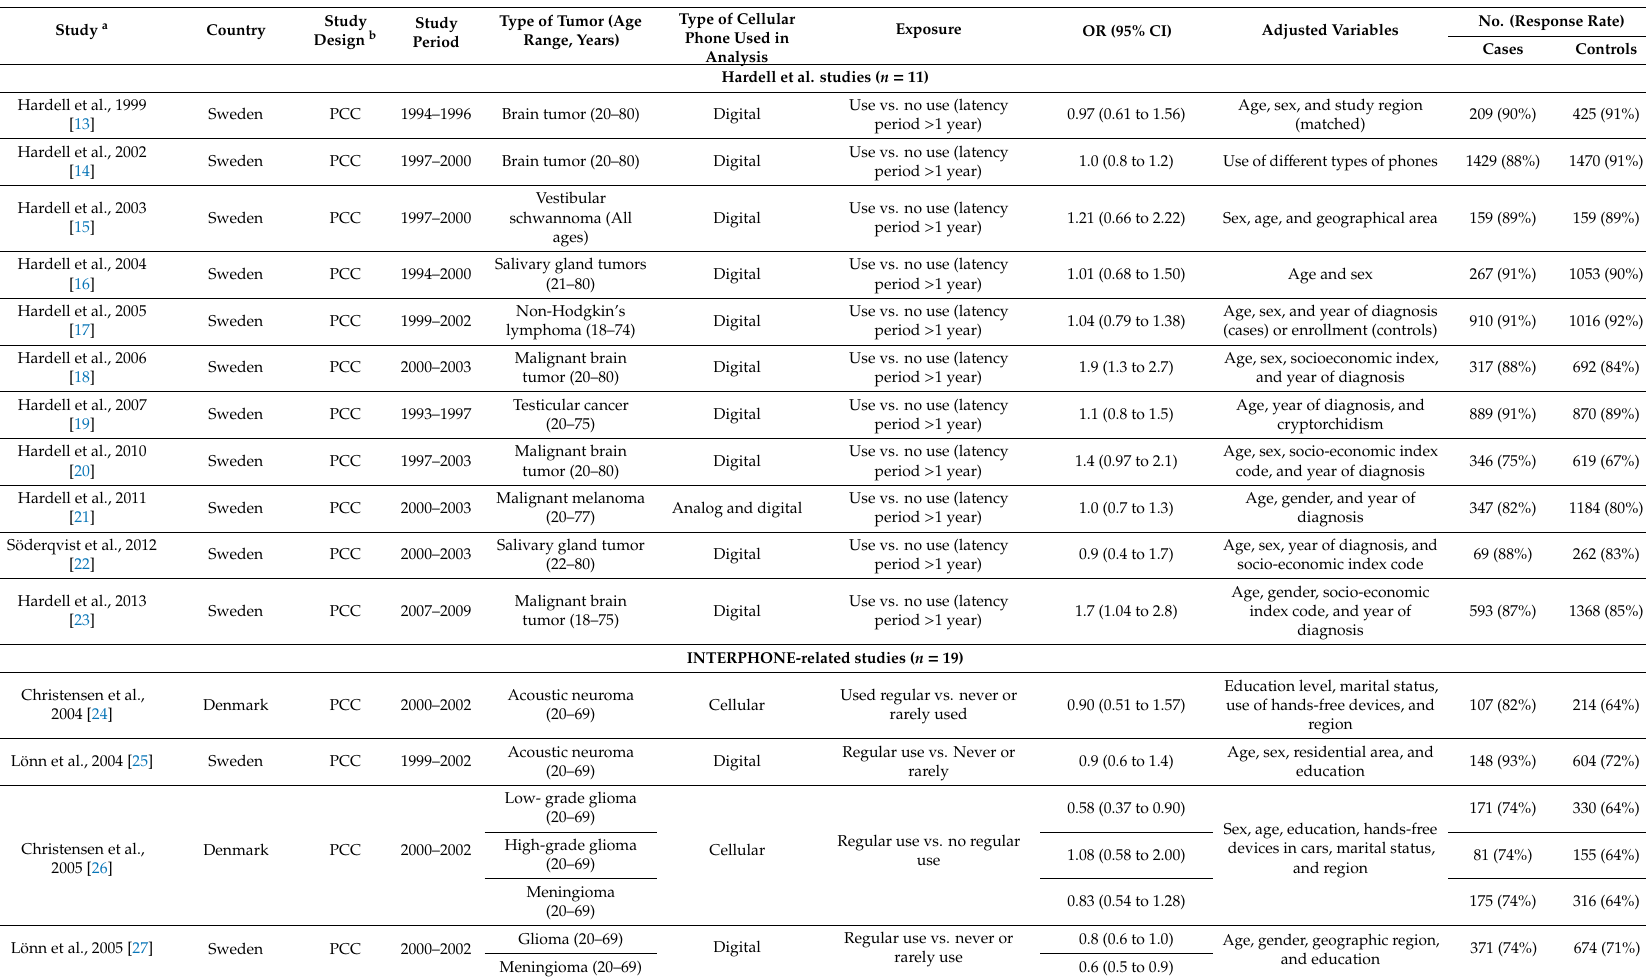
Table 1. General characteristics of studies included in the meta-analysis ( n =